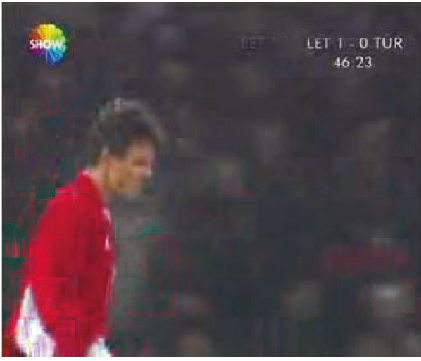
Figure 4: An example of blockiness distortion, coded with SNR scaling at 100